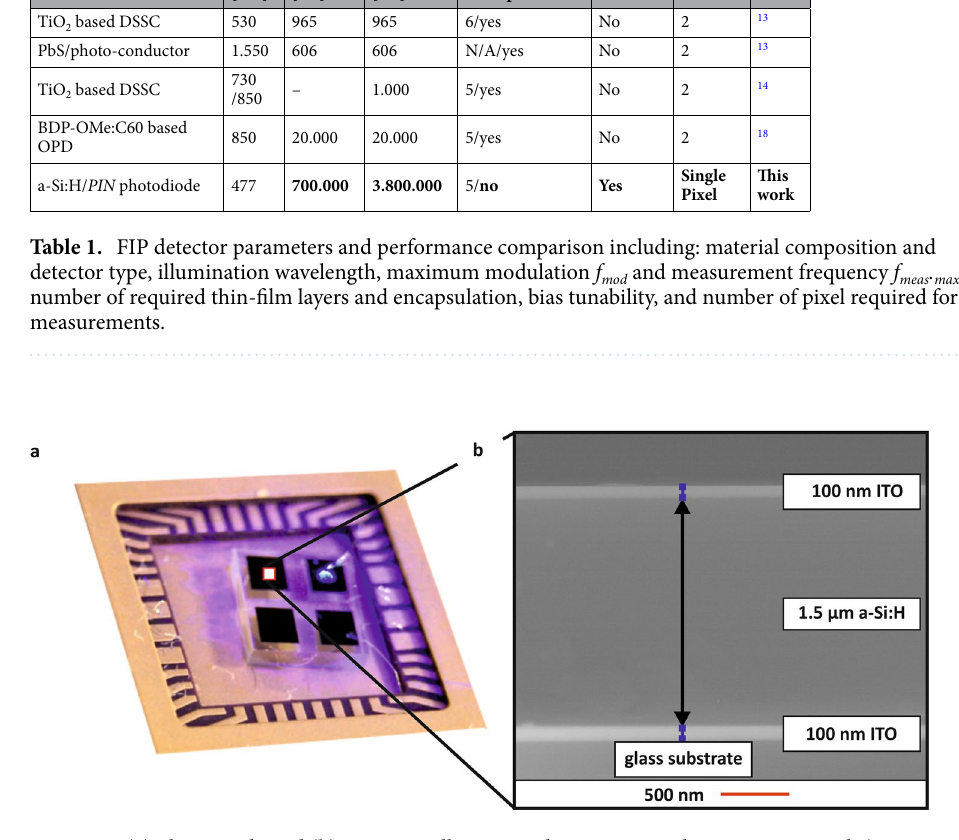
Figure 6. ( a ) Photograph, and ( b ) geometrically corrected cross-sectional ESEM micrograph (owing FIB cross- sectioning) of an a-Si:H PIN FIP